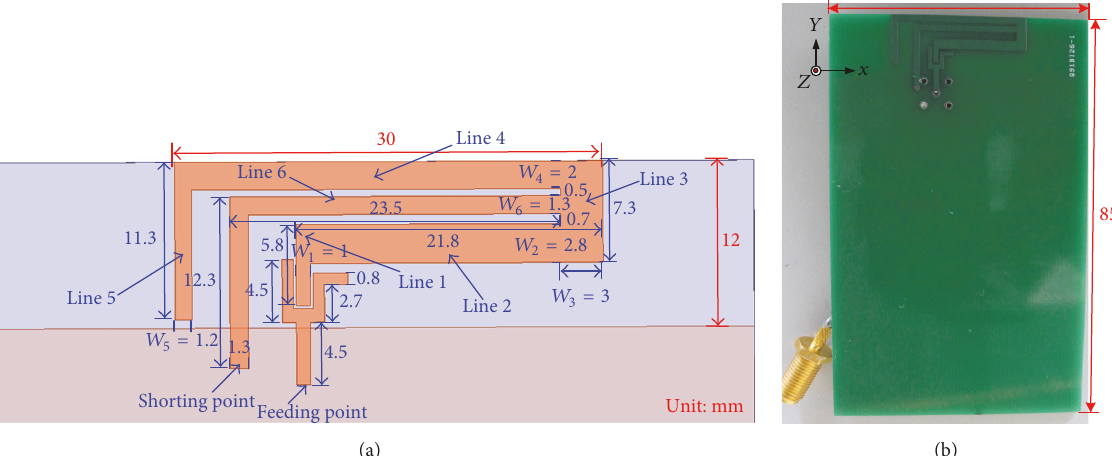
Figure 1: Configuration of the proposed antenna on a 1.6 mm FR4 substrate. (a) Detailed dimensions of radiating element (front view). (b) Photo of the antenna prototype.